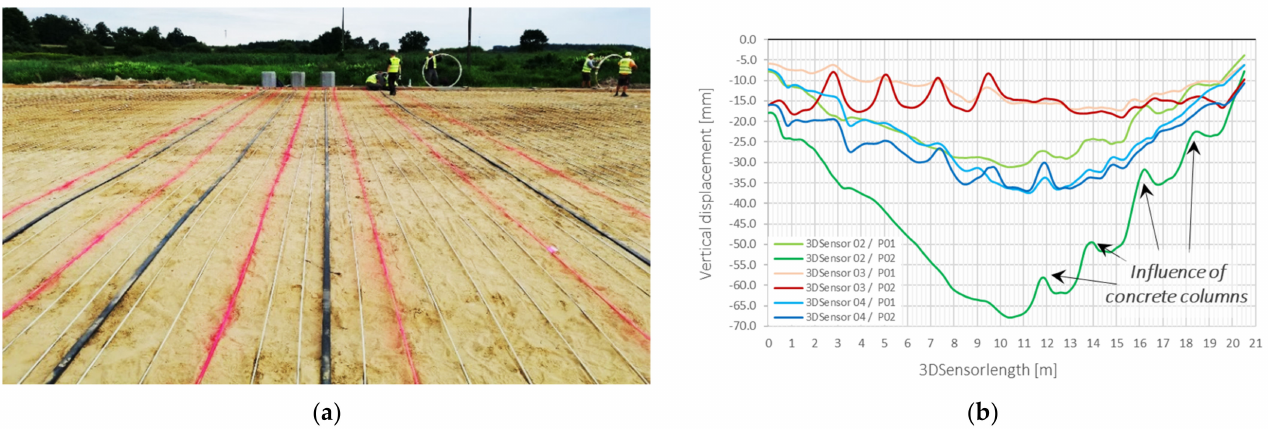
Figure 29. Embankment above the substrate strengthened with concrete columns: ( a ) 3DSensors’ installation; ( b ) example measured displacement profiles with visible influence of concrete